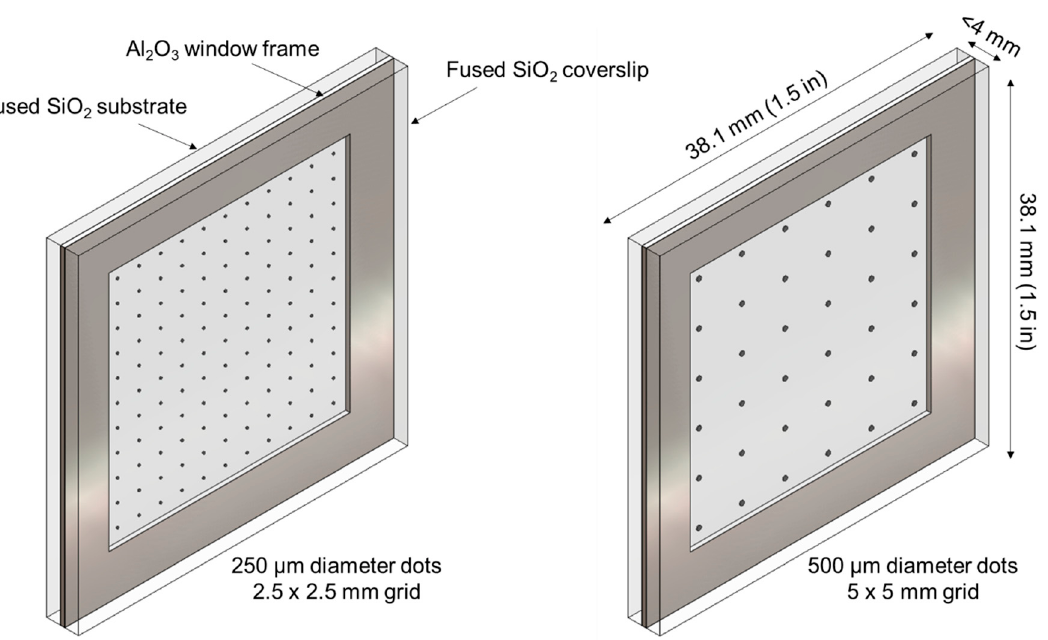
Figure 4. Design of environmentally sealed BB grids with thick film printing of Gd 2 O 3 dots. A standard thick film screen printing approach was used to deposit the patterns. For both pattern types, a 325 mesh stainless steel screen (50.2 μ m opening, 27.9 μ m wire